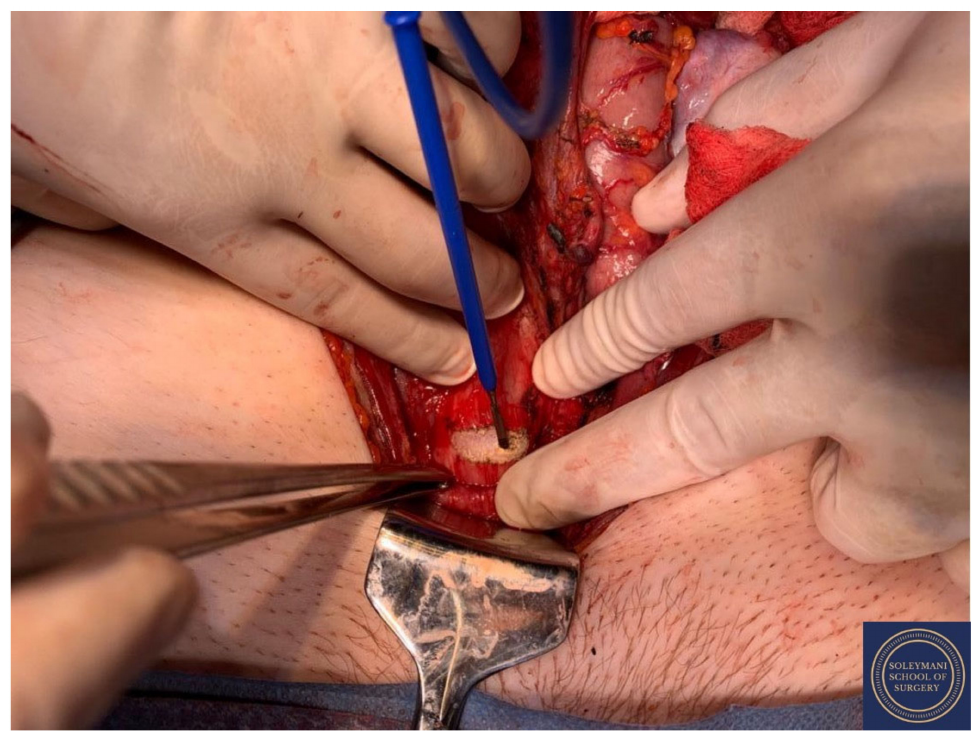
Figure 14. The colpotomy was approached anteriorly using a circumferential incision.